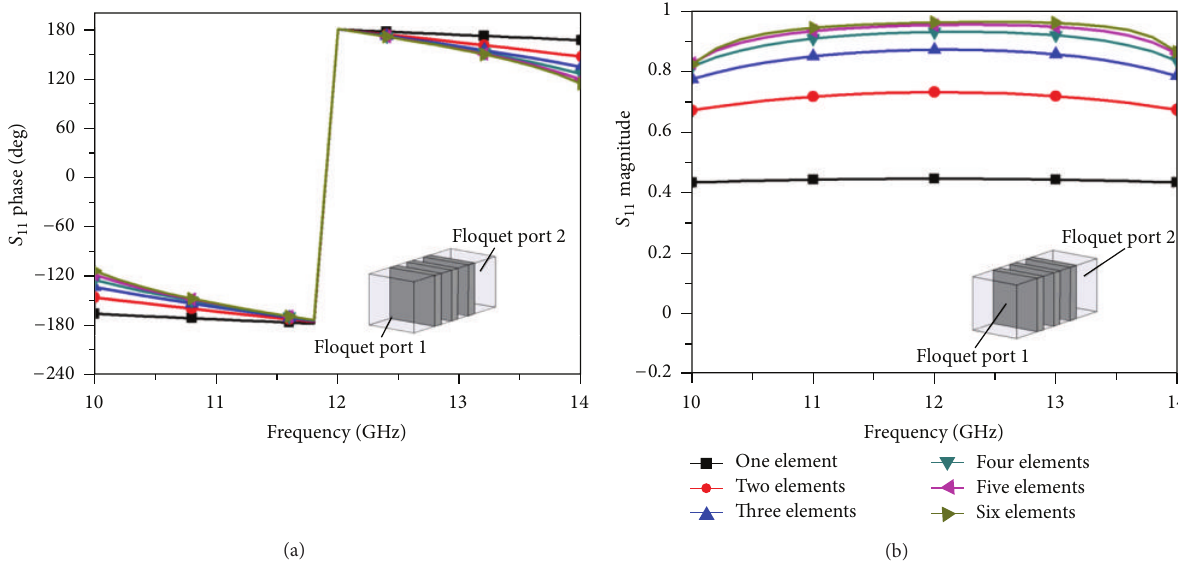
Figure 3: Simulated phase and magnitude of reflection coefficients ( 𝑆 11 ) of the dielectric EBG structure with different elements, (a) reflection phase (b) reflection magnitude.